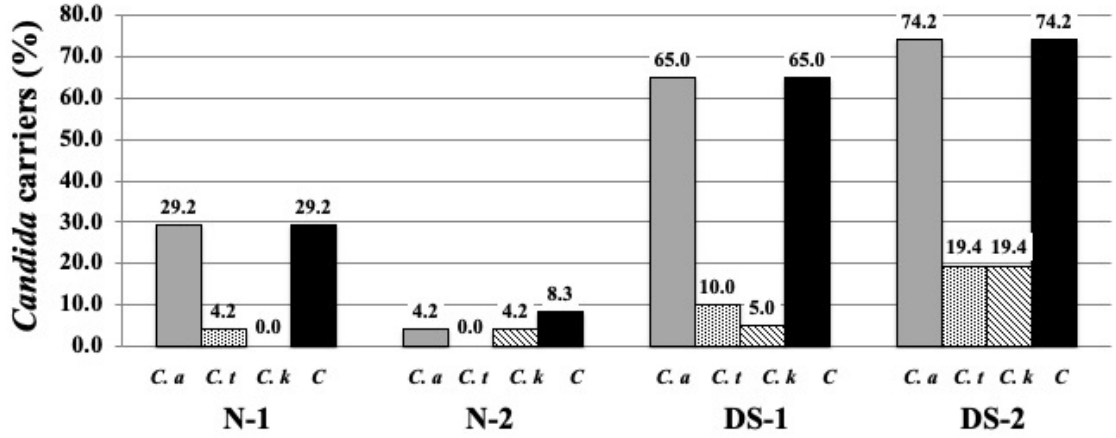
Figure 1. The distributions of Candida carriers by percentage in the study group and normal group. Candida species were isolated from the center of the dorsal surface of the tongue from individuals with Down syndrome (DS) and healthy normal (N) individuals. The DS and N groups were subdivided according to age: group 1 consisted of DS (DS-1) and normal (N-1) subjects under 20 years of age, and group 2 consisted of DS (DS-2) and normal (N-2) subjects over 40 years of age, as shown in Table 1. The distributions of Candida carriers by percentage in the DS group and N group are shown. The gray bars represent the distributions of C. albicans carriers by percentage in the study group and normal group. The dotted bars represent the distributions of C. tropicalis carriers by percentage in the study group and normal group. The cross-hatched bars represent the distributions of C. krusei carriers by percentage in the study group and normal group. The black bars represent the distributions of the total number of Candida carriers by percentage in the study group and normal group. C. a: C. albicans, C. t: C. tropicalis, C. k: C. krusei, C: total number of